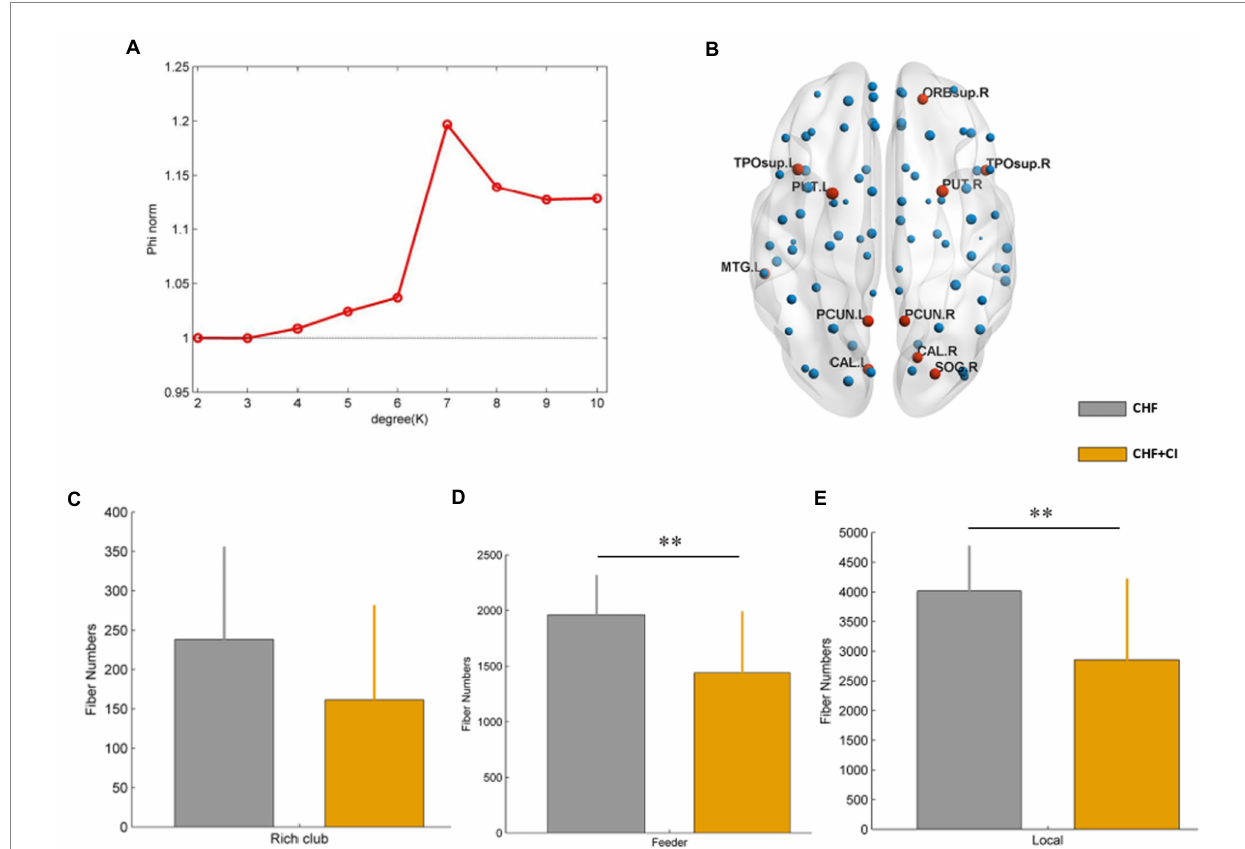
FIGURE 5 The rich-club coefficient of the group average network is calculated (A) . The brain regions were selected as rich-club brain regions (red nodes) and non rich-club brain regions (blue nodes). (B) No significant difference in rich-club connection strength between the CHF group and the CHF + CI group. (C) The connection strength of feeder connection ( p < 0.01) and local connection ( p < 0.01) in CHF + CI group was significantly reduced. (D,E) (** p <